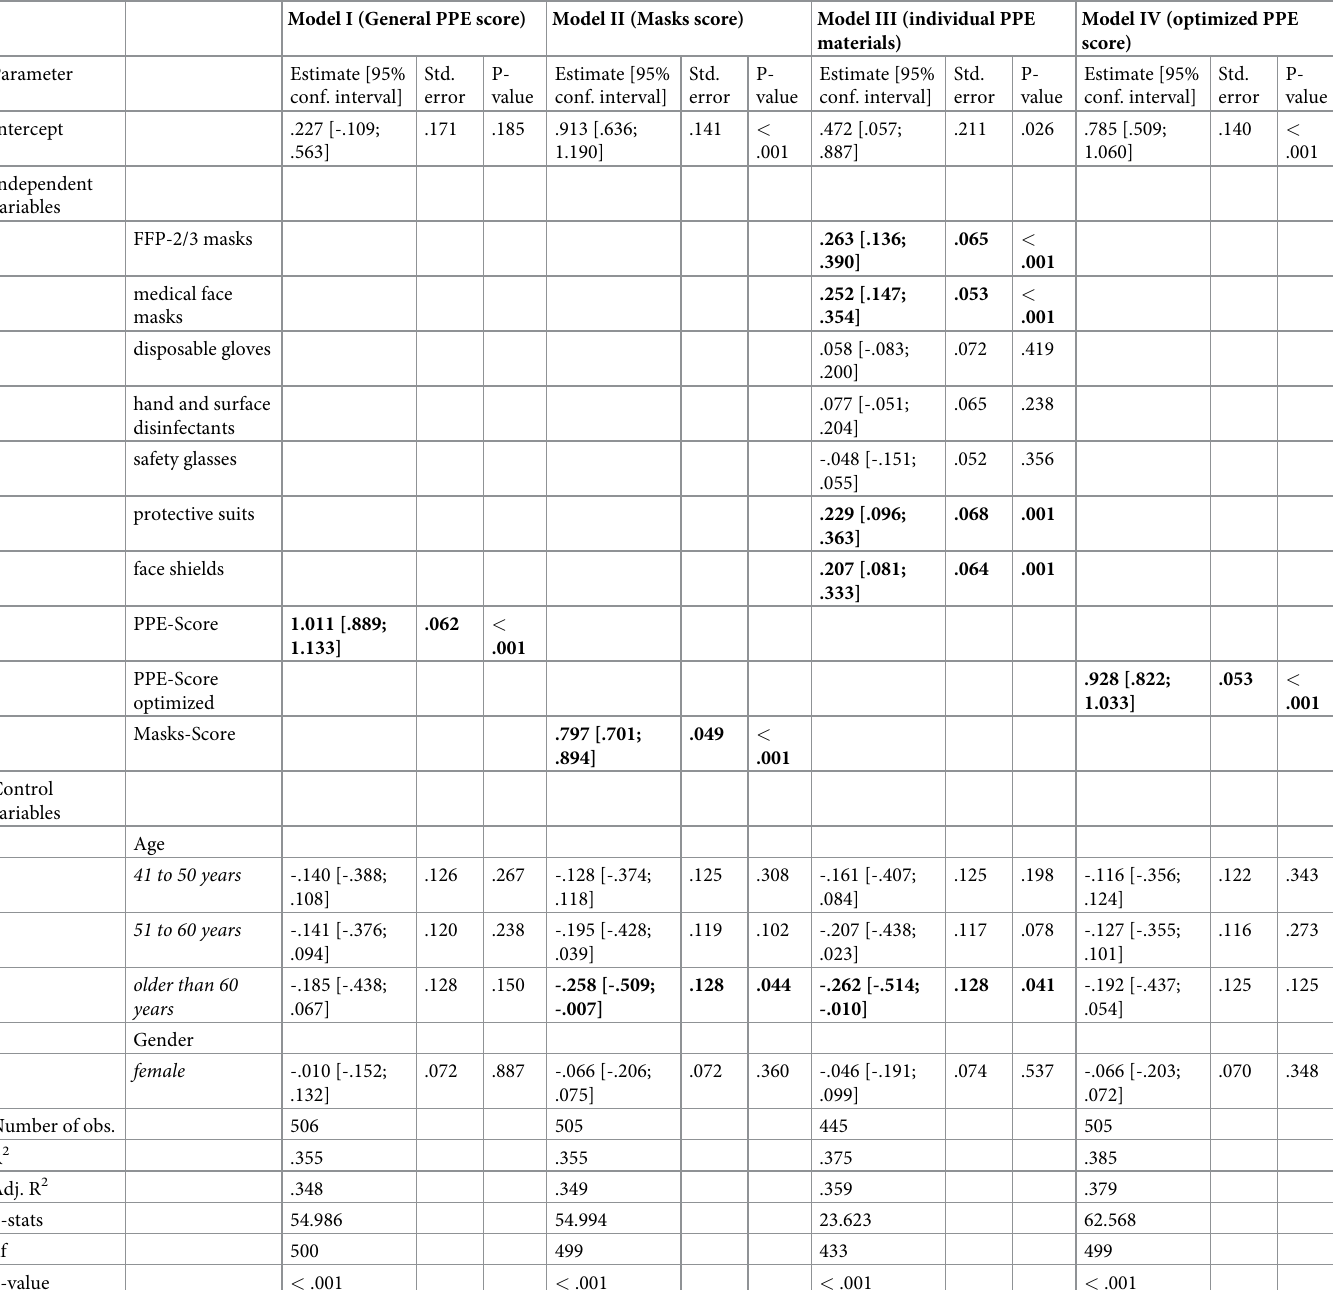
Table 3. Multivariable linear regression model on personal protective equipment and pandemic preparedness among general